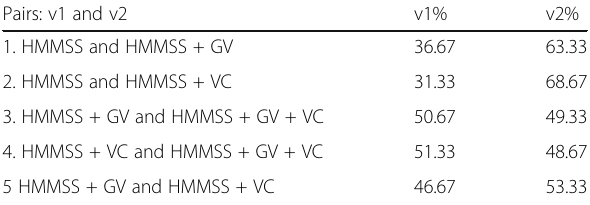
Table 2 Average preference for pairwise comparison Pairs: v1 and v2 v1%